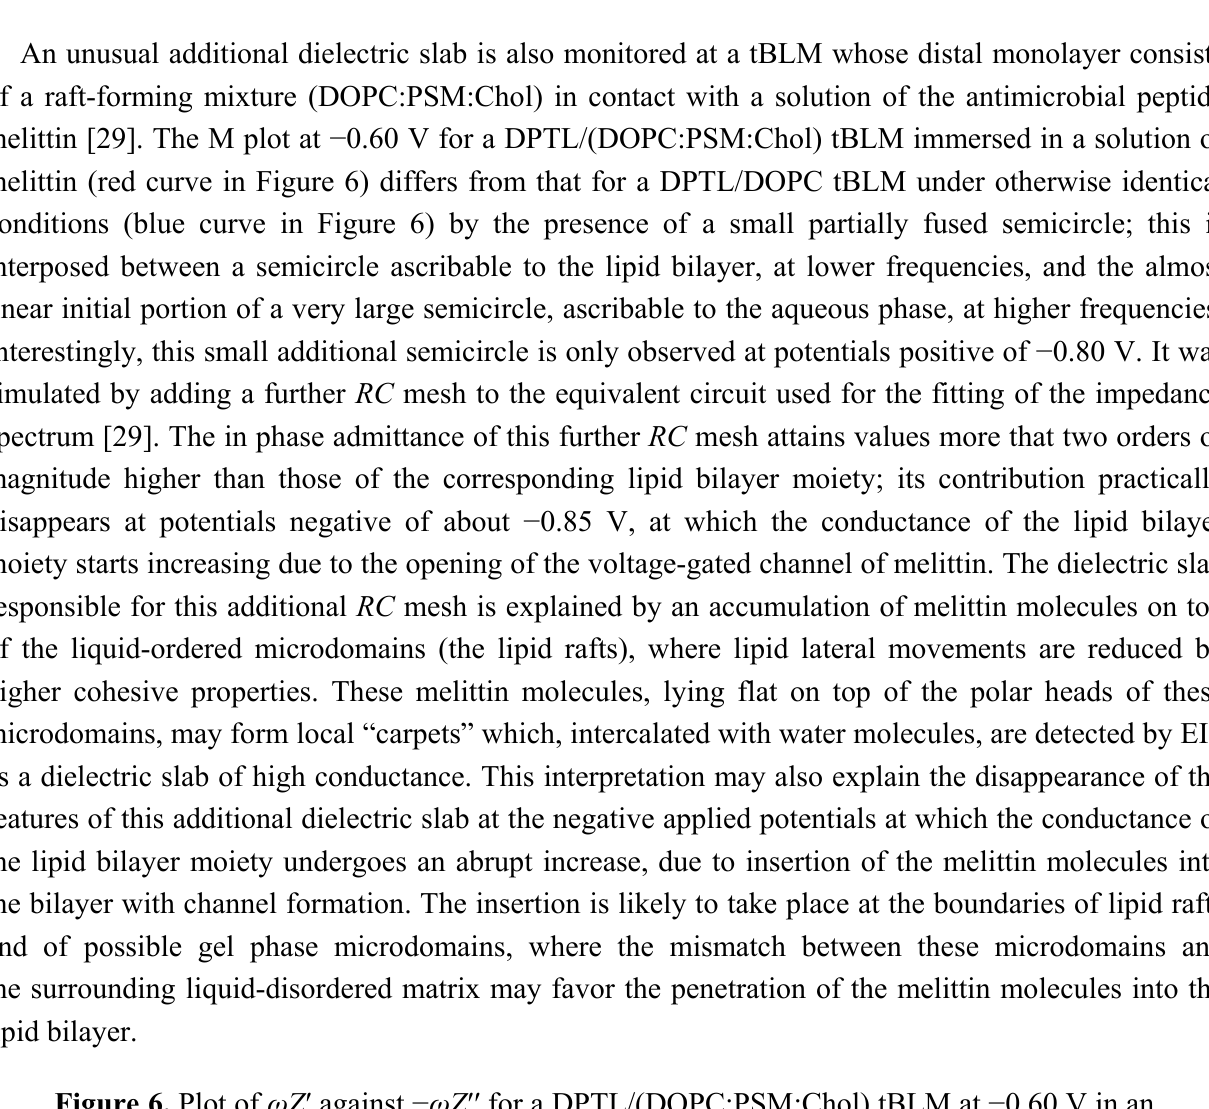
Figure 6. Plot of ω Z ′ against − ω Z ′′ for a DPTL/(DOPC:PSM:Chol) tBLM at − 0.60 V in an aqueous solution of 0.1 M KCl and 1.4 × 10 − 7 M melittin (red curve) and for a DPTL/DOPC tBLM in the same solution (blue